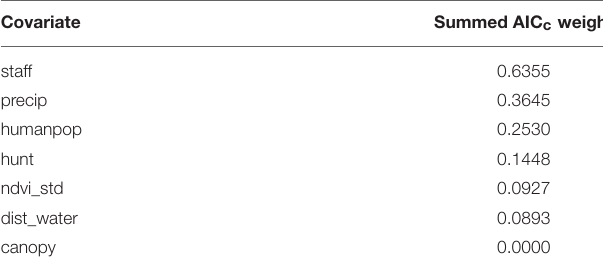
TABLE 5 | Summed AIC c weights of all covariates in the final model